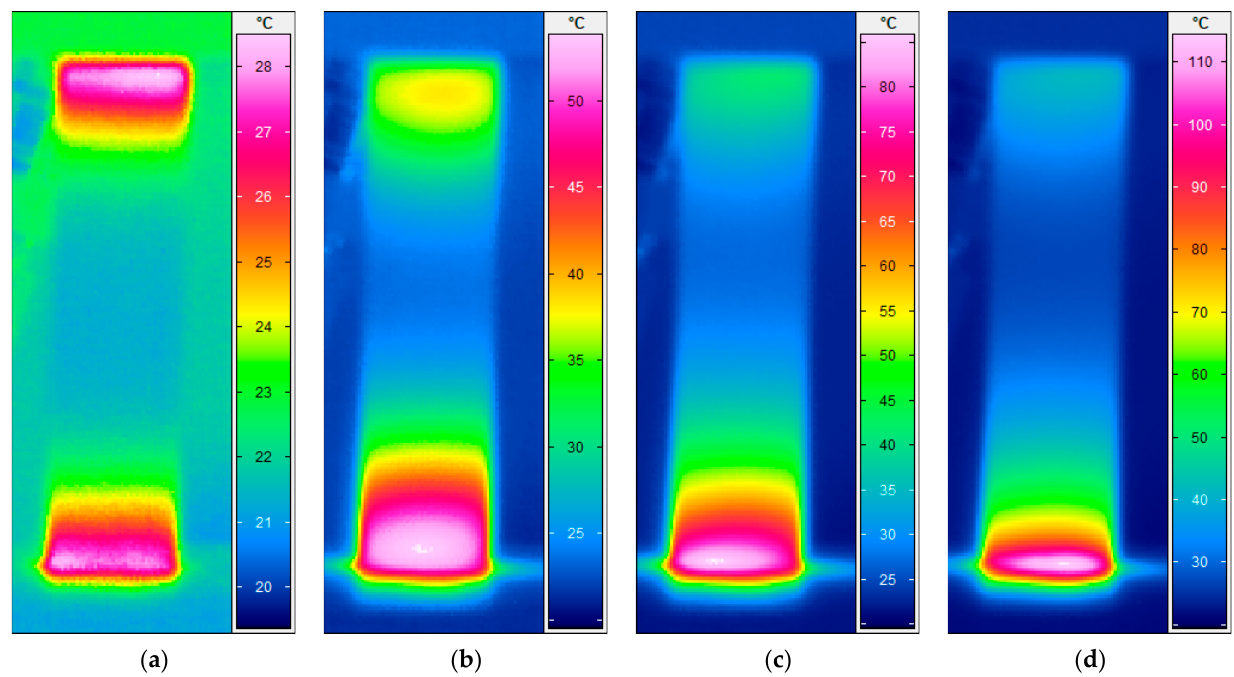
Figure 26. Infrared images of the cyclically loaded GFRP specimen with self-heating effect at ( a ) the beginning of loading (phase I), ( b ) near the end of phase II, ( c ) in the middle of phase III and ( d ) at failure.